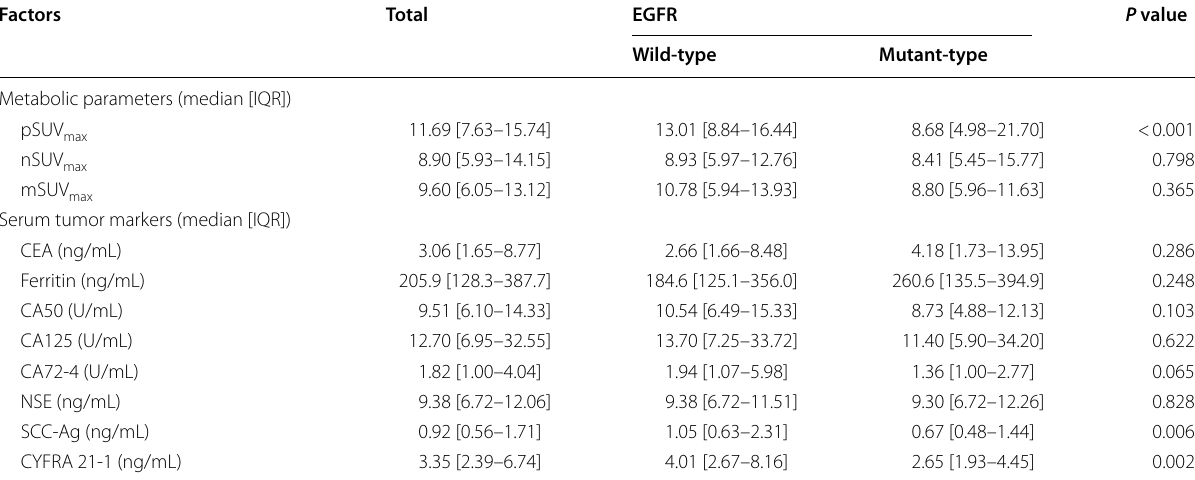
Table 2 Comparison of metabolic parameters and quantitative serum tumor markers between EGFR wild-type and mutant-type male patients with NSCLC